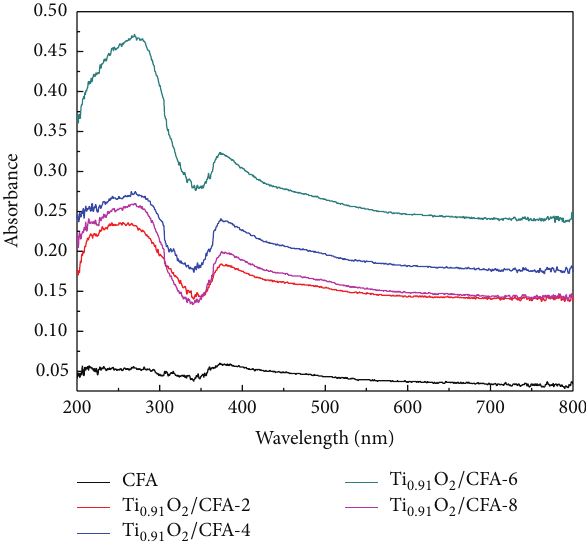
Figure 3: UV-vis absorption spectra of CFA and Ti 0.91 O 2